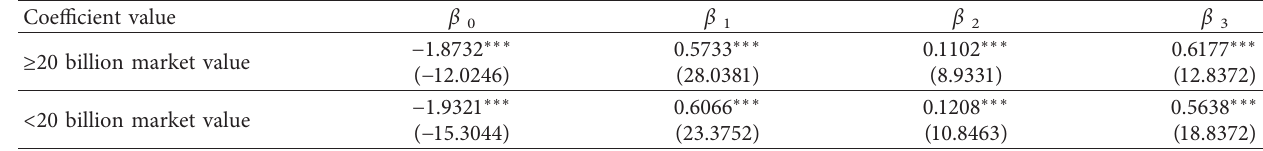
Table 7: Empirical test results of herding behavior with different market value scale.